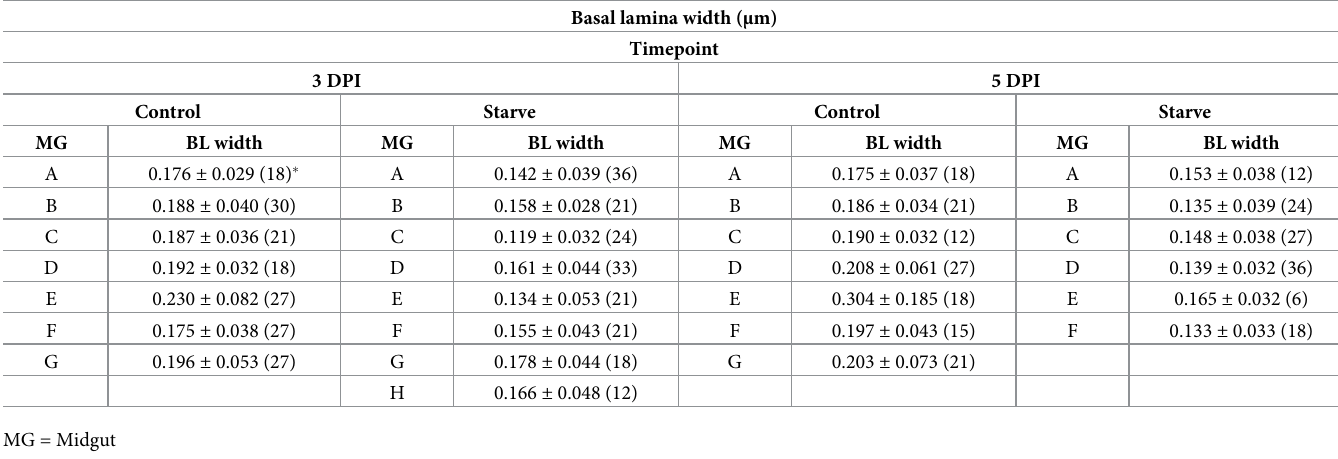
Table 2. Mean basal lamina width ( μ m) ± standard deviation (SD) in midguts of adult Ae . aegypti reared under Control and Starve diet regimens at 3 and 5 days post-infection with orally acquired ZIKV I-44.